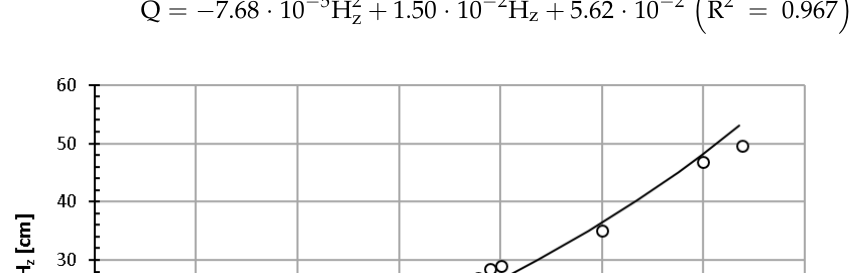
Figure 7. Flow discharge Q curves of the hole regulator for different heights H h of the open hole.